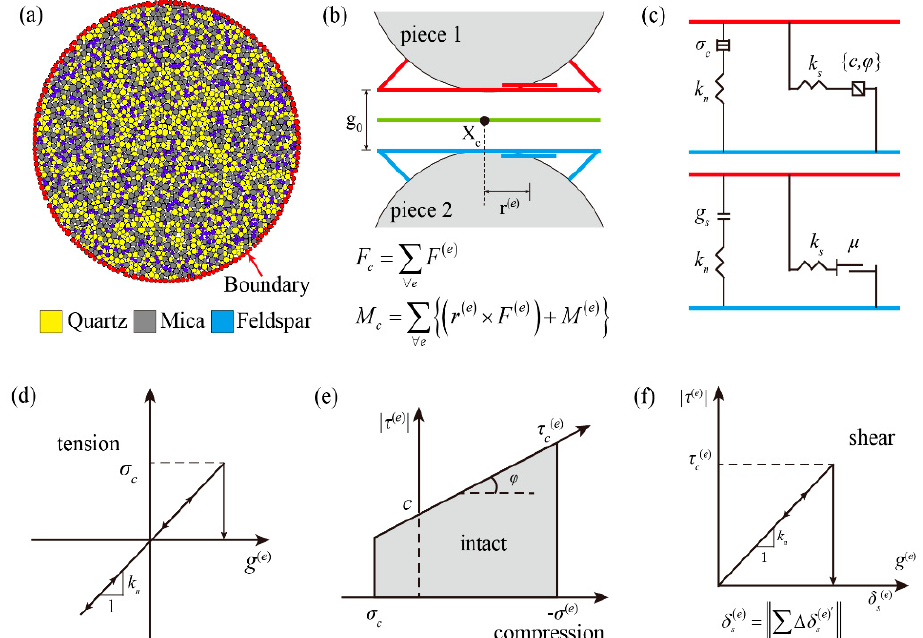
Figure 5. Schematic diagram of DEM: ( a ) numerical model, ( b ) contact between two adjacent particles, ( c ) schematic diagram of the contact, ( d ) tensile failure criterion of the contact, ( e ) compression failure criterion of the contact, ( f ) shear failure criterion of the contact. Note: F c and M c are contact force and moment; g represents the gap between two adjacent particles.